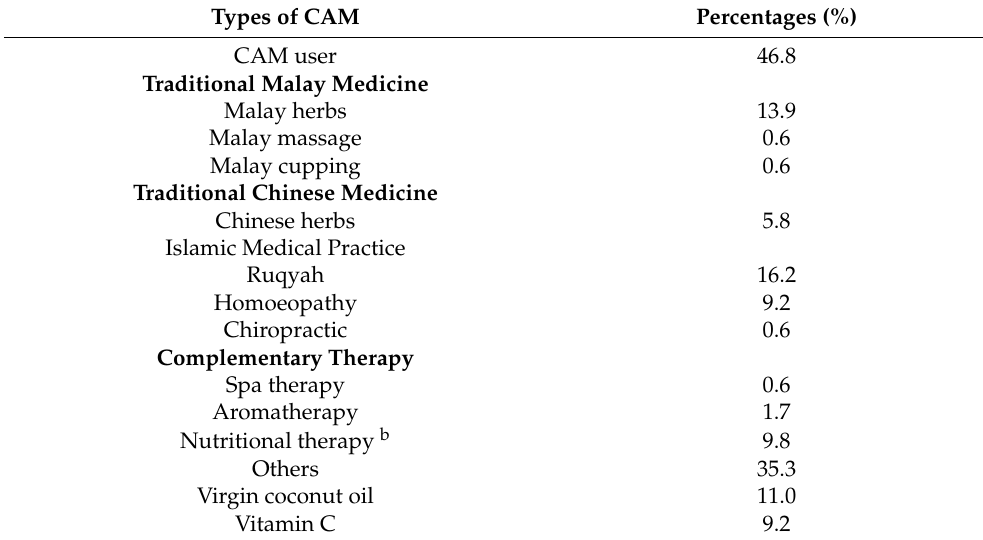
Table 1. Types of complementary and alternative medicine (CAM) used in children with AD at